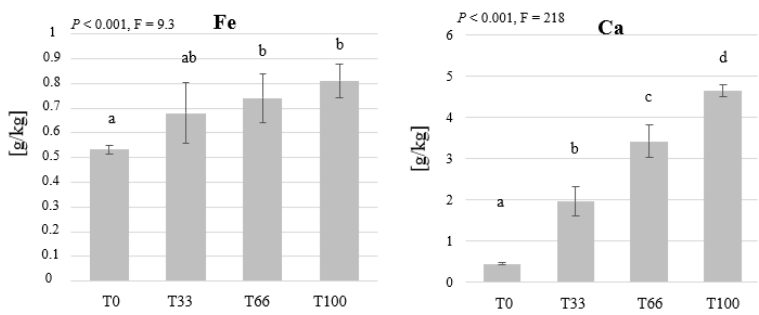
Figure 7. The mass fraction of protein, P, Mg, K, Fe, and Ca in mealworm larvae grown on substrates that contain different ratios of hemp material. Mealworm larvae were fed with wheat bran (T0), 67% bran and 33% hemp (T33), 34% bran and 66 hemp (T66), or 100% hemp (T100). The means and the standard deviations are shown in the graph. One-way ANOVA (n = 5, p < 0.05) revealed significant differences between the treatments in the crude protein and Fe mass fractions. Kruskal-Wallis test revealed significant differences in K, Mg, P, and Ca mass fractions. Significant groups are indicated by different letters.